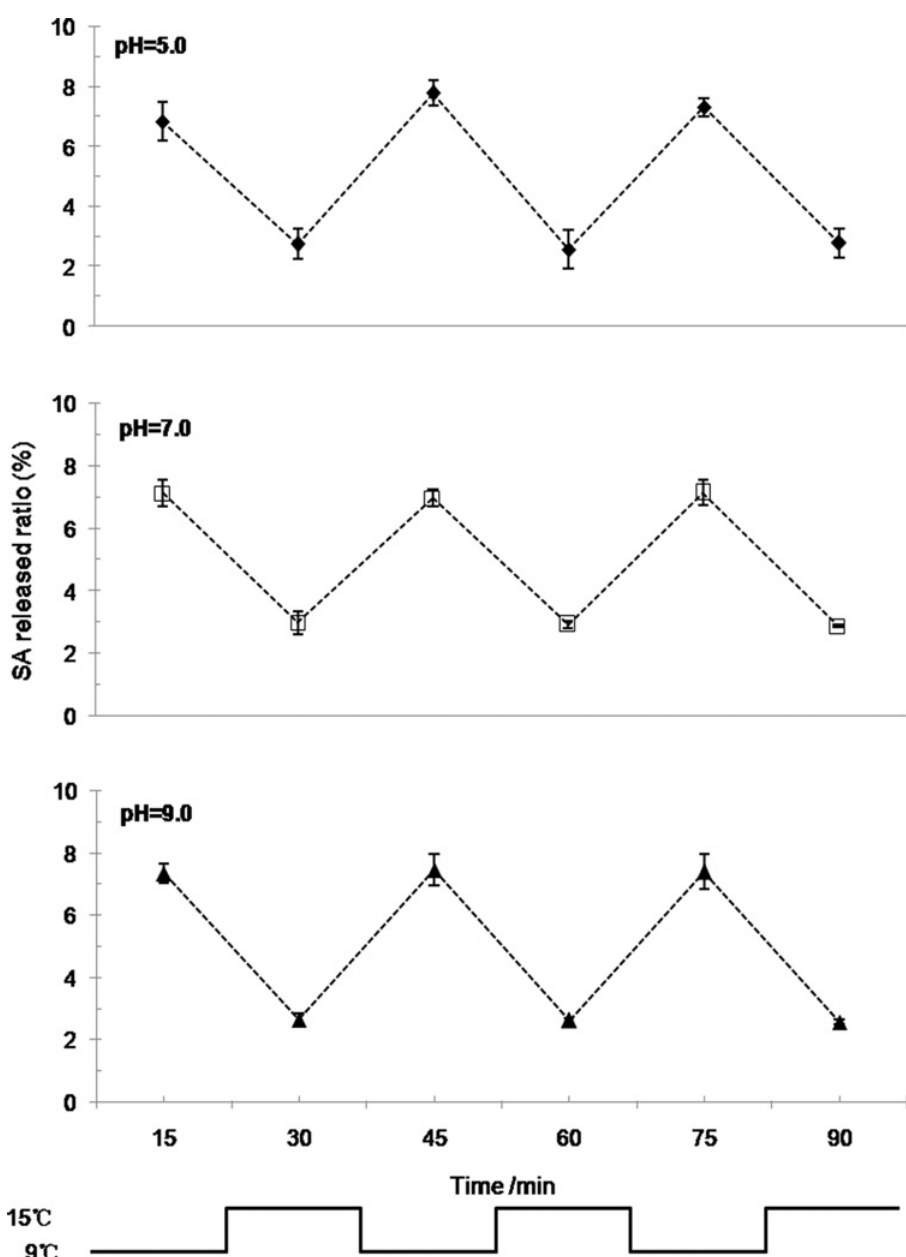
Fig 6. The effect of pH on SA release from the P(NIPAm- co -BMA) hydrogel under circulative pulse temperatures. P(NIPAm- co -BMA) is poly (N-isopropyl acrylamide- co -butylmethacrylate) and SA is salicylic acid. The pulsatile SA releases from the hydrogel under phosphate buffer solutions with different pH values (pH = 5, 7, 9). The circulative pulse temperature changes between 9°C and 15°C every 15 min. Error bars represent ±